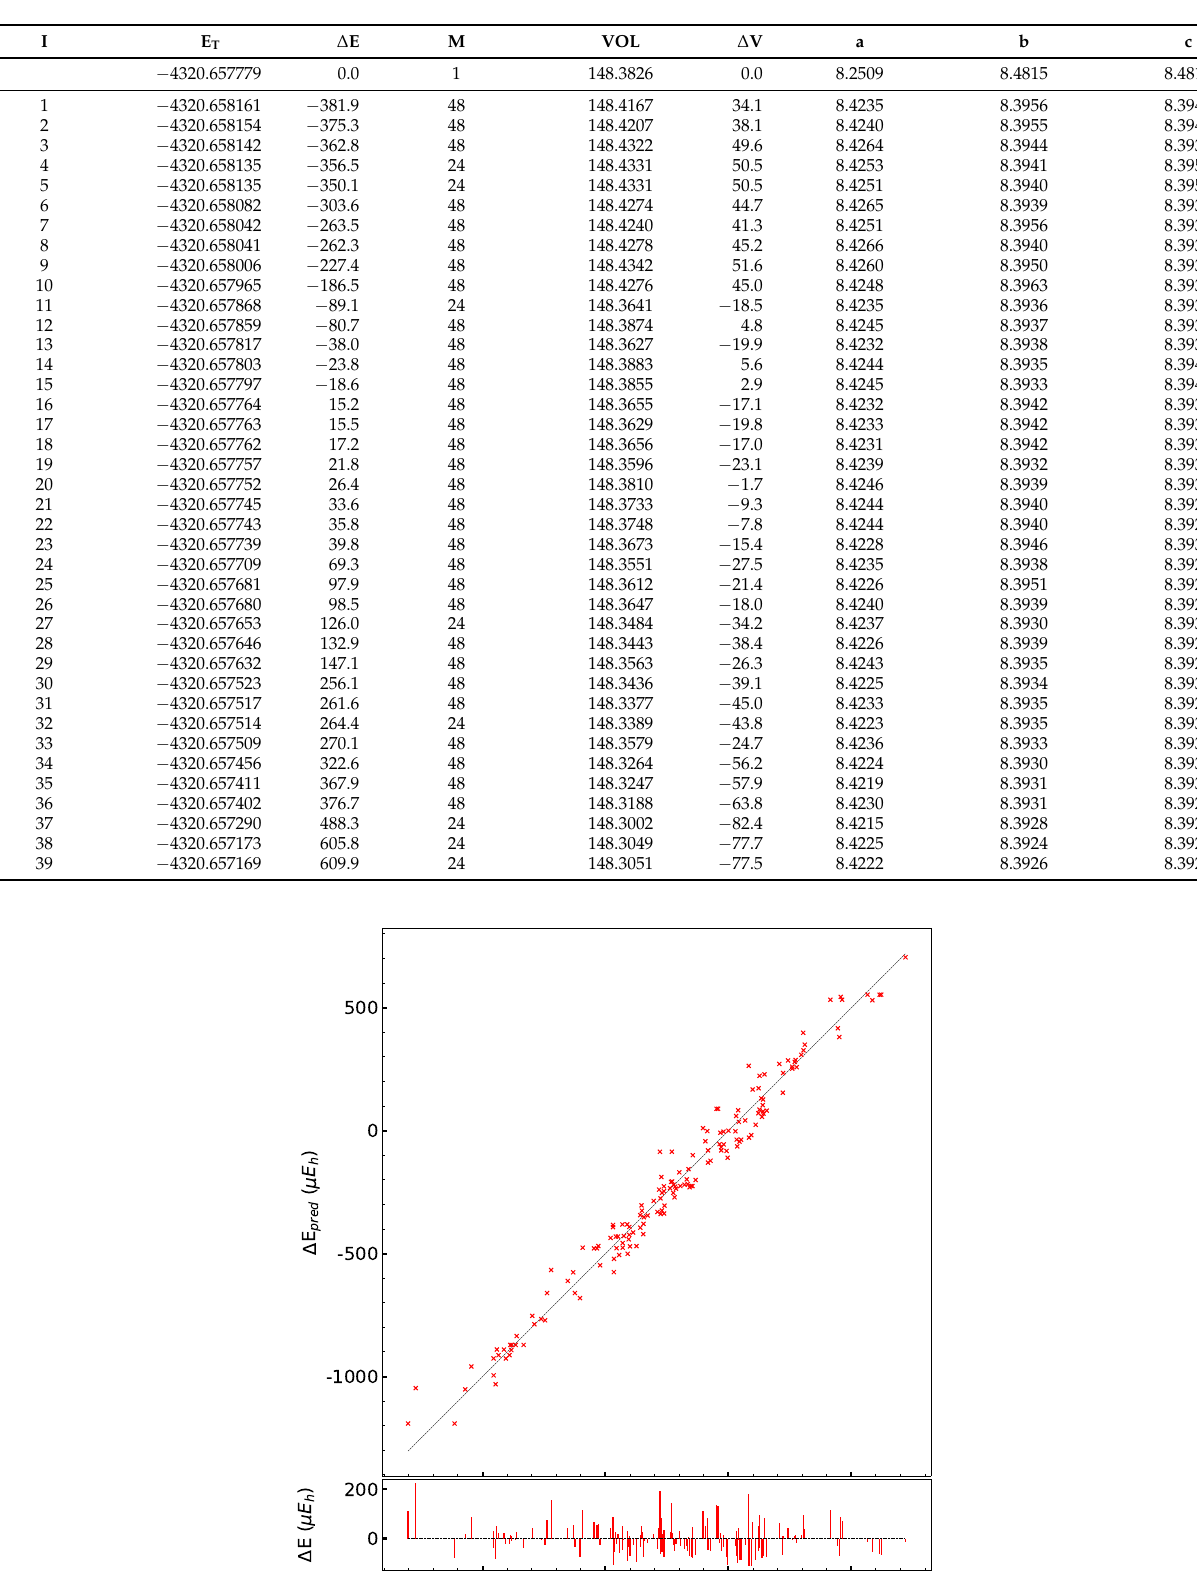
Table A8. As Table A6, for UHF.